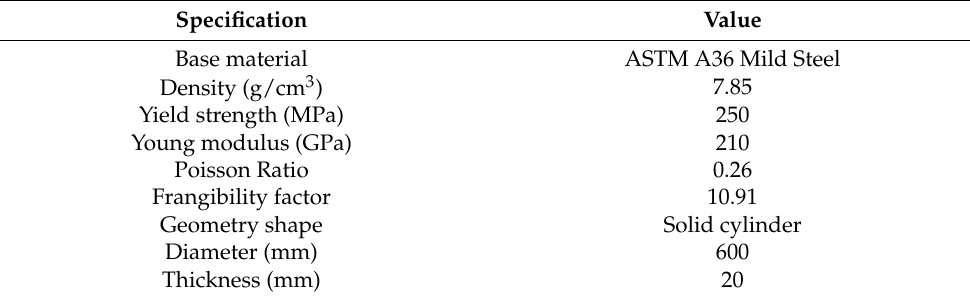
Table 3. Steel plate mechanical